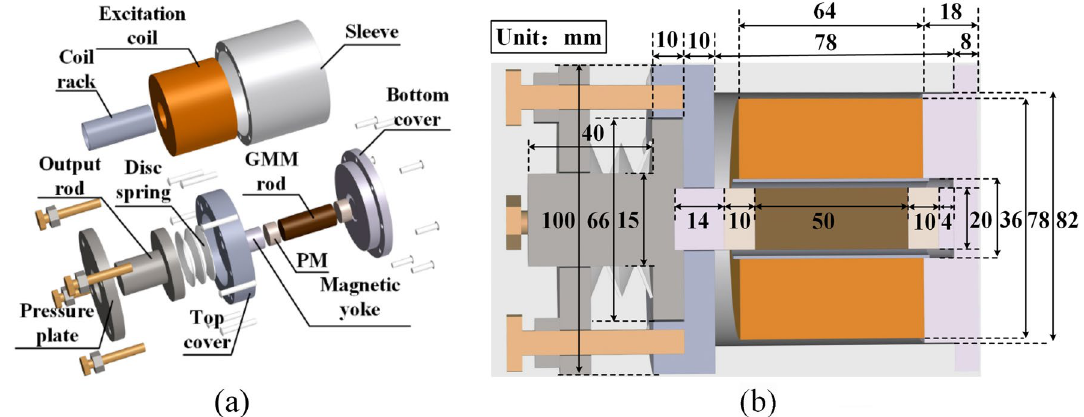
Figure 1. Longitudinal vibration GMT: ( a ) configuration diagram, ( b ) dimension diagram.